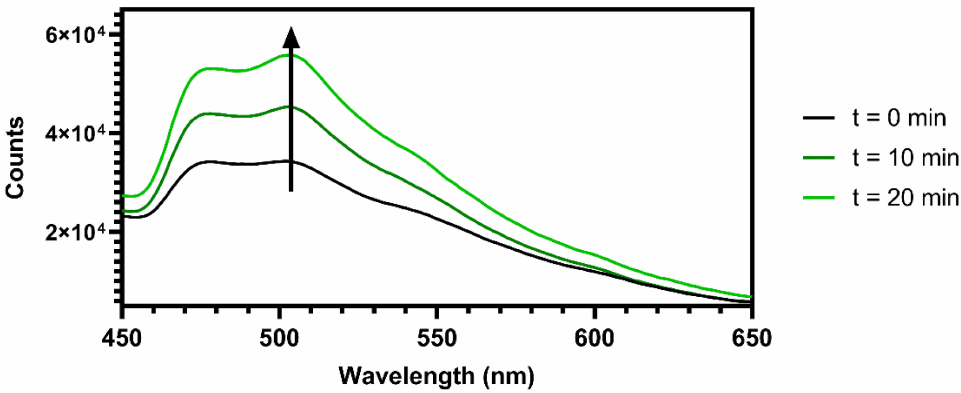
Figure 5. Oxygen sensing capabilities of MCC-Ir. The emission spectra of a suspension of MCC-Ir in water were recorded by excitation at 310 nm (slits 5 nm) after bubbling N 2 gas into the solution for different amounts of time, revealing emission enhancement over time due to the removal of oxygen triplet species. The arrow indicates decreasing O 2 content in